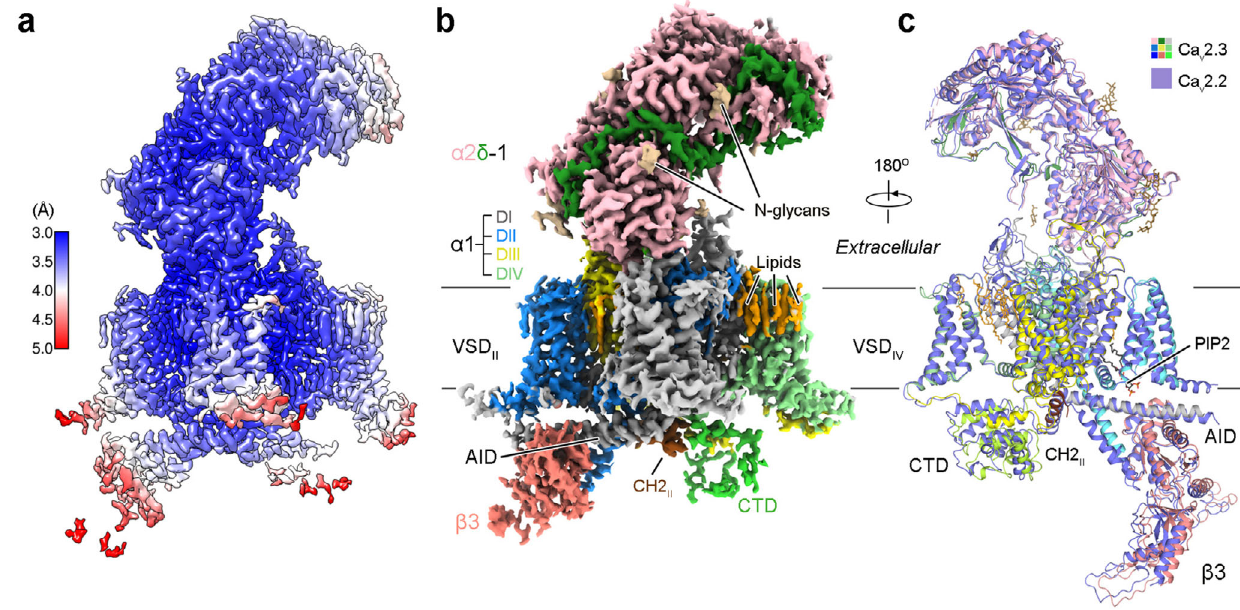
Fig.1|Cryo-EMstructureofthehumanCa v 2.3complex.a Heatmapforthelocal resolutions of the Ca v 2.3 EM reconstruction. The map, calculated in RELION, was generated in ChimeraX. b 3D EM map of human Ca v 2.3 complex comprising the extracellular α 2 δ − 1subunit(lightpinkfor α 2,andgreenfor δ ),thetransmembrane α 1 subunit (domain-colored), and the cytosolic β 3 subunit (salmon). The cytosolic helix of repeat II, designated as CH2 II , is colored chocolate. Sugars and lipids are coloredwheatandorange,respectively.Alsolabeledarethe α 1-interactingdomain (AID)andthecarboxy-terminaldomain(CTD).Thesamecolorschemeisappliedto